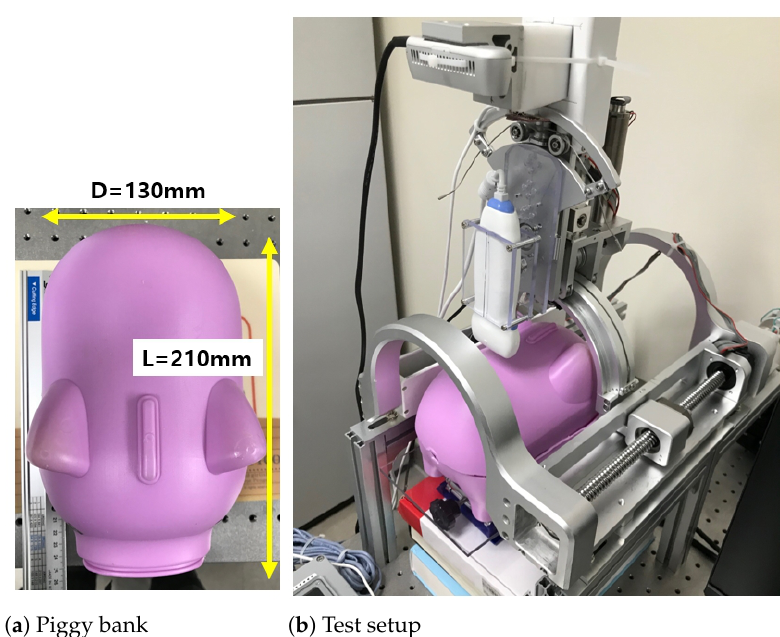
Figure 5. The enhanced piecewise arc curve fitting test setup. The piecewise arc curve fitting result by the proposed method is in Table 1 and Figure 6. The total number of points extracted from the example in Figure 6 was 1164; there were 12 outlier points, as seen in the upper-left portion of Figure 6. The algebraic fitting result and geometric fitting result in Table 1 are almost the same: there is a less than 0.1 mm difference in center points and a less than 0.15 mm different in radius, which means that the acquired point cloud is very circular. The total error and average error in Table 1 were calculated by Equations (1) and (2), which are the same as Equations (1) and (2) in [26]. In Equations (1) and (2), p ref _ ji represents the reference points shown as point data in Figure 6. p fitting _ ji represents the resultant fitting points, which are the green fitting results in Figure 6. Note that j is arc number and i is the point number for each arc. In Equations (1) and (2), M and N are the total arc number and total point number in each arc. For Table 1 and Figure 6, N was set to 1164/2 = 582 (points) and M was set to 2. The total error and average error of geometric fitting (Table 1) were approximately 80.32 mm and 0.069 mm, respectively, which could be considered good arc fitting results for 1164 points.